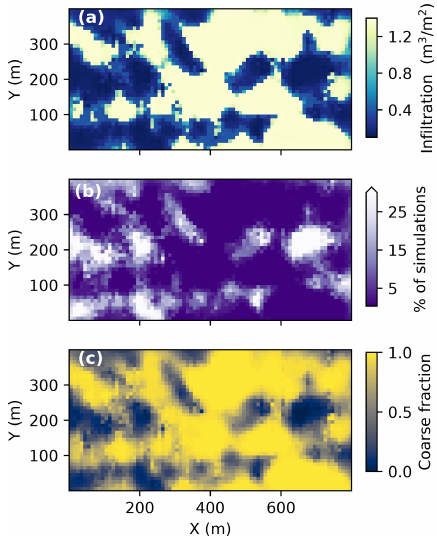
Figure 4. Maps of the first two outcomes of interest, aggregated across all 284 simulations. All simulations received 0.8m of inun- dation, though the median volume of water that infiltrated into each surface cell (a) ranges from 0.10 to 1.40m 3 m − 2 . The percent of simulations in which each surface cell exceeded the 48h root zone saturation threshold is shown in panel (b) , with the median coarse fraction of each surface cell shown in panel (c) . Note that each map only shows the portion of the model domain immediately below the almond